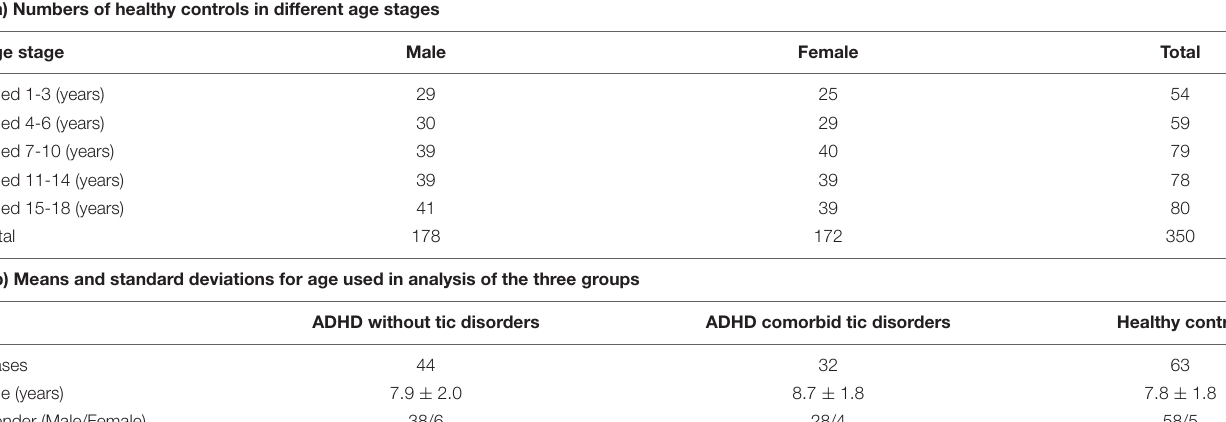
TABLE 1 | Basic characteristics of the subjects enrolled in this